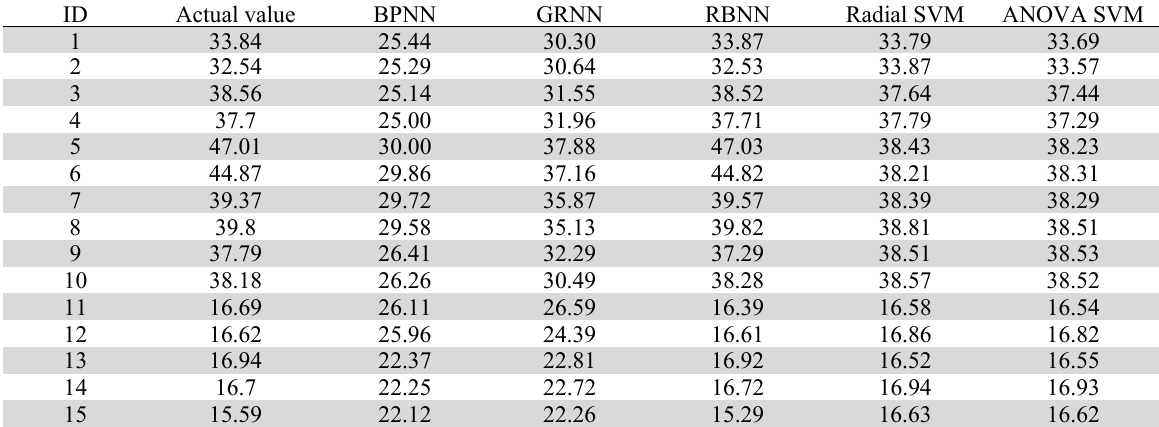
Predicted cooling loads using the five machine learning models ID